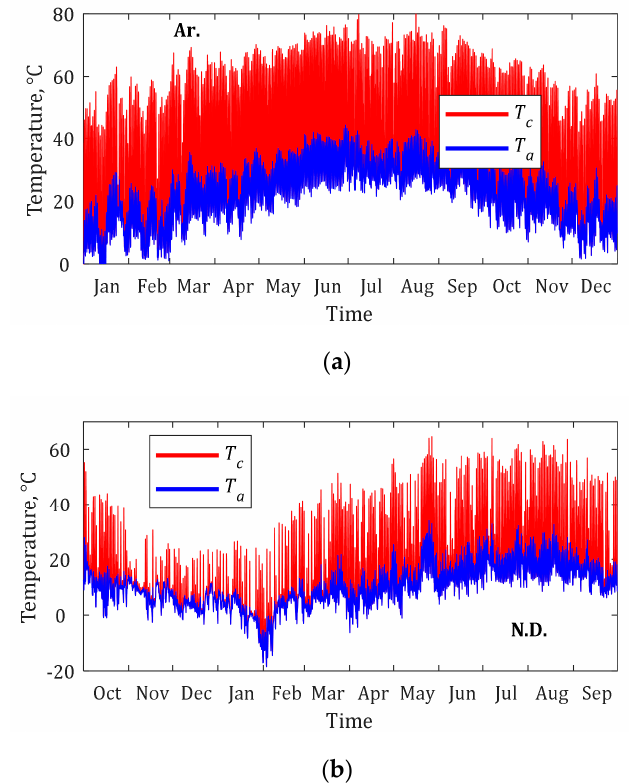
Figure 11. Annual profiles for experimental ambient temperature and estimated cell temperature for Arizona ( a ) and North Denmark ( b ) geographic locations.